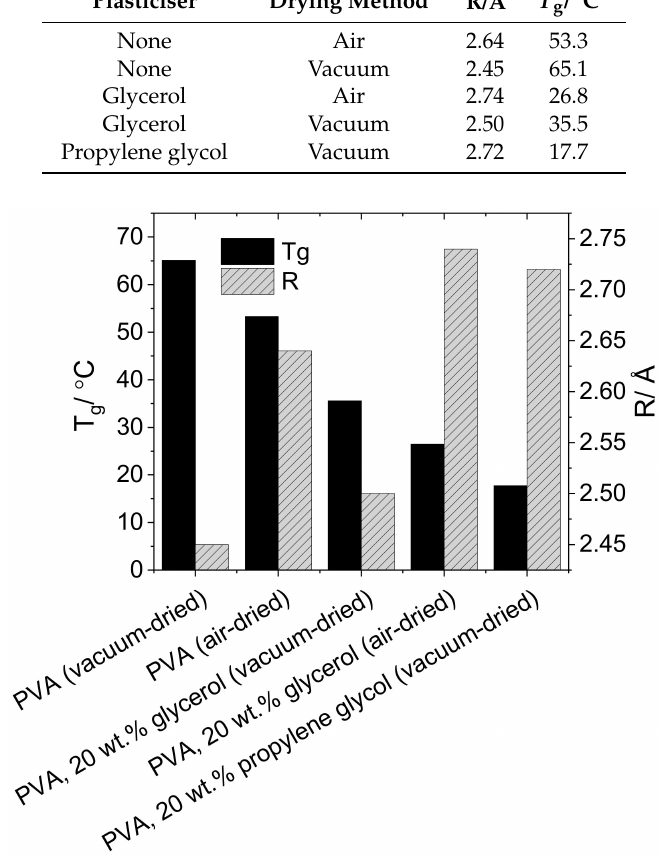
Figure 5. Glass transition temperatures and cavity radii for solution cast PVA resins with both in the presence and absence of